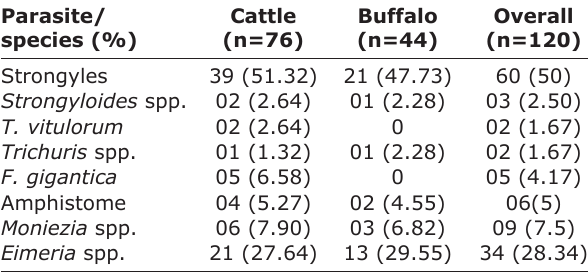
Table-2: Parasite wise prevalence of GI parasites in cattle and buffaloes. Parasite/ species (%)